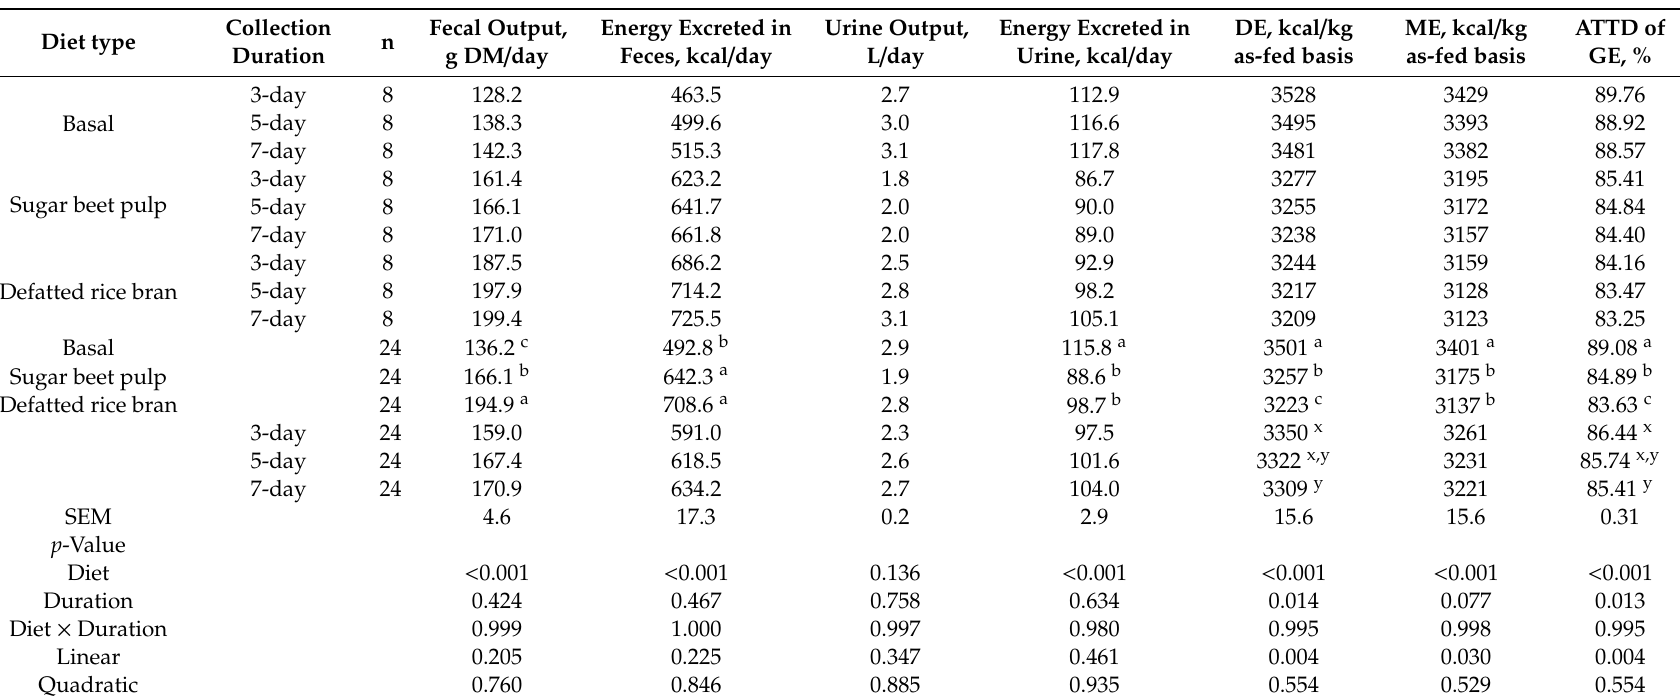
Table 3. E ff ects of collection duration on the energy value and gross energy digestibility for experimental diets fed to growing pigs 1